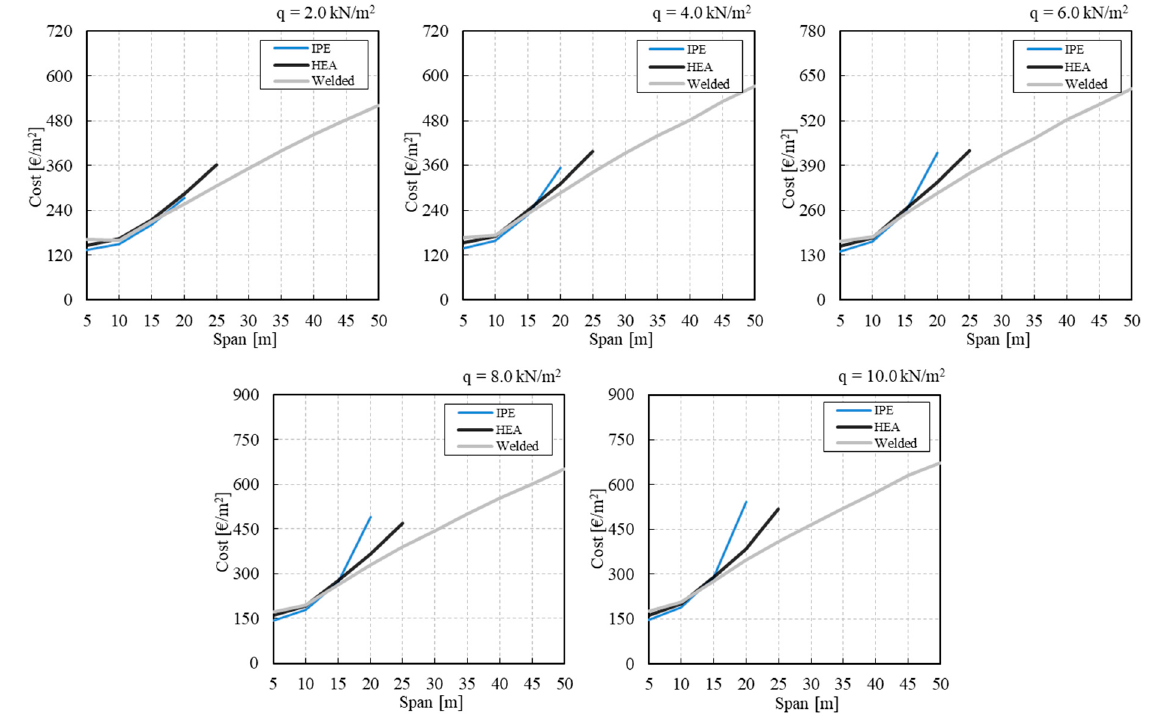
Figure 9. Comparative diagrams of the optimal energy life-cycle costs for the high energy consumption case (ELCC HEC) of the CFS structures with welded and standard IPE and HEA sections.